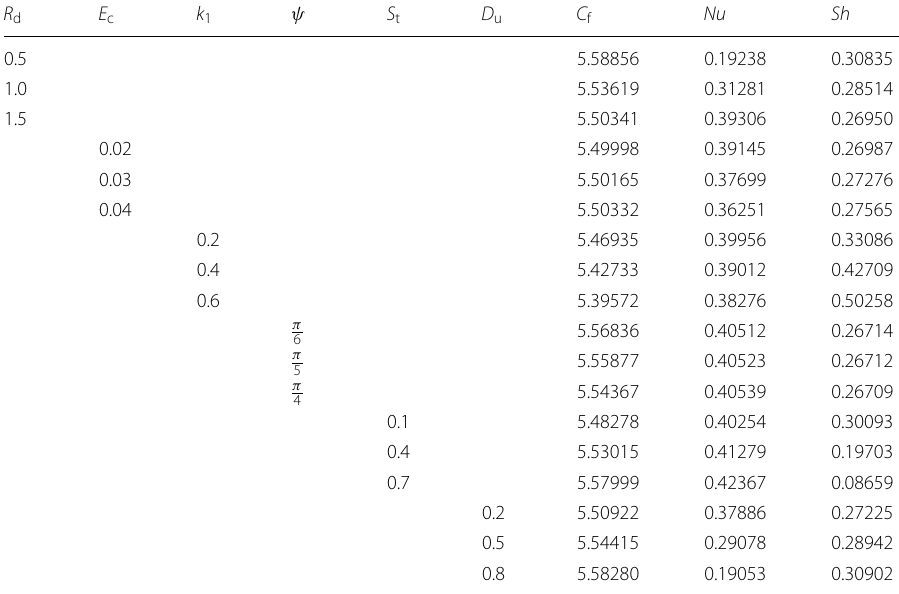
Table 6 Values of skin-friction, Nusselt number and Sherwood Number for different